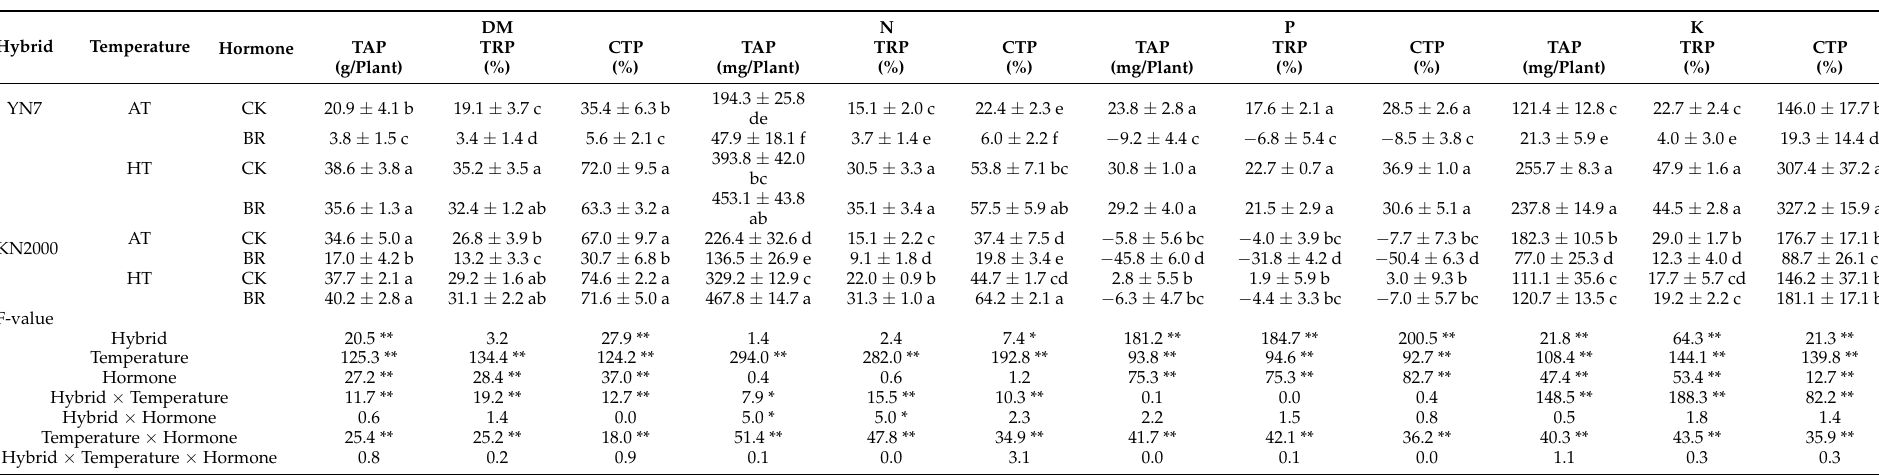
Table 1. Effects of exogenous BR application at the silking stage on the translocations of pre-silking DM and nutrient of waxy maize under post-silking ambient and high